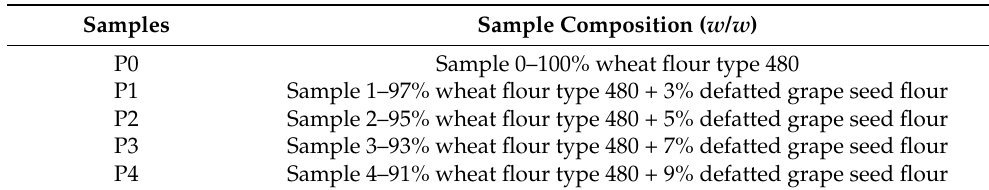
Table 1. Coding of experimental samples with the addition of partially defatted grape seed flour.